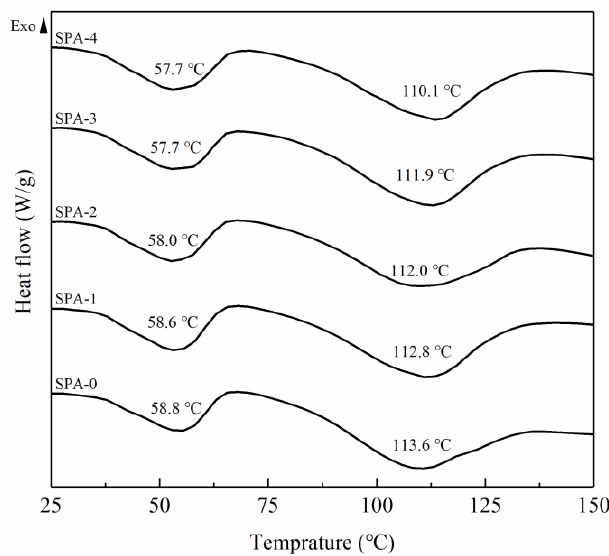
Figure 4. DSC thermograms of starch/PBAT antibacterial films loaded with different levels of AgNPs@SiO 2 .